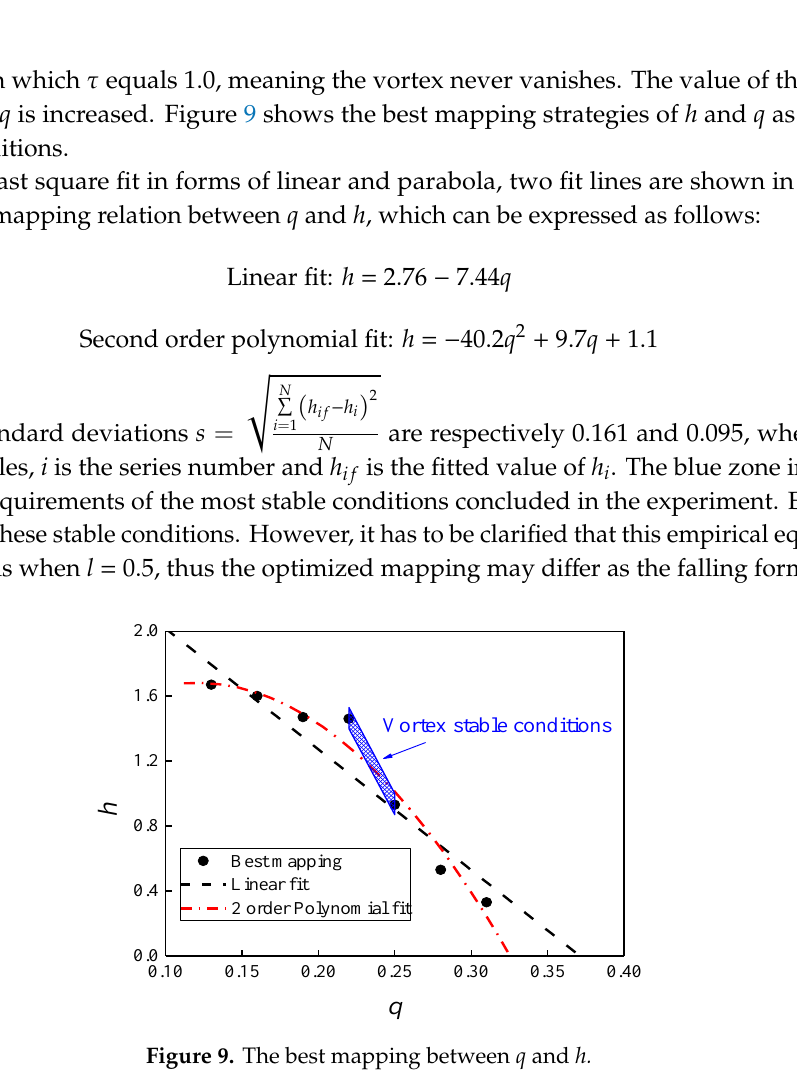
Figure 8. Relationship between  and h under different dimensionless discharges ( q ) ( l = 0.5).